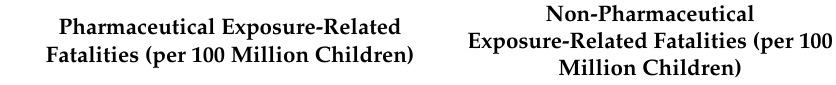
Table 3. Population-adjusted Annual Rates of Poison Exposure-related Fatalities per 100,000, by Type and Children Age Range,